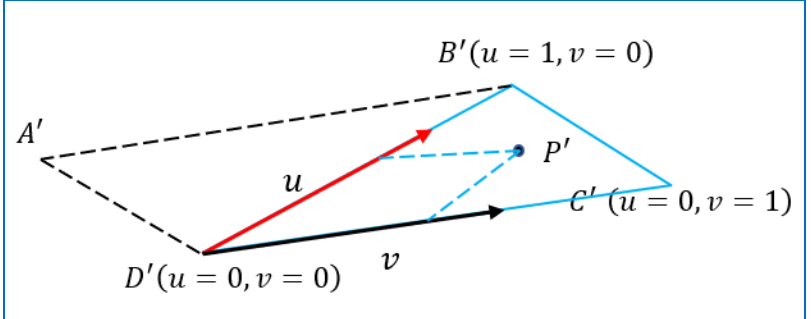
Figure 9. The triangular barycentric coordinate method.